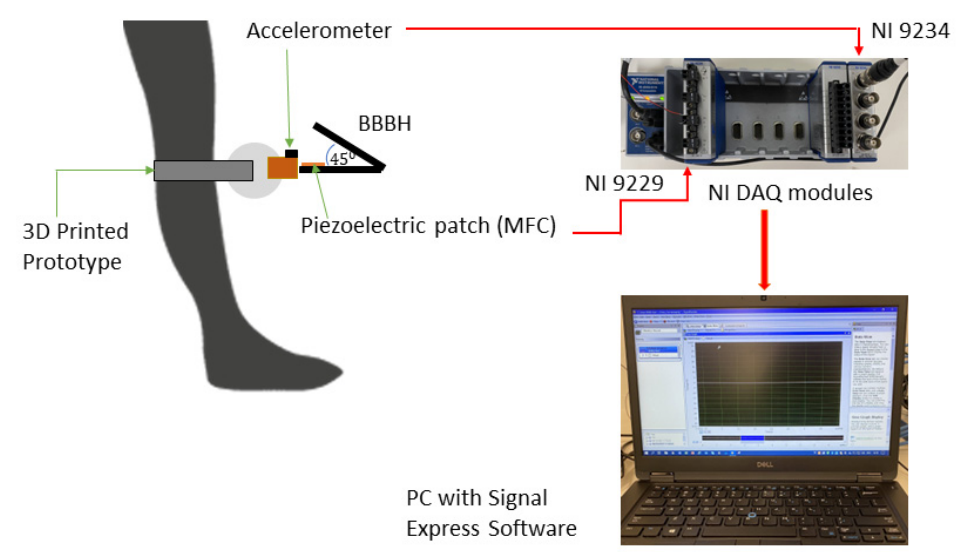
Figure 5. Schematic of experimental setup for the human motion test.